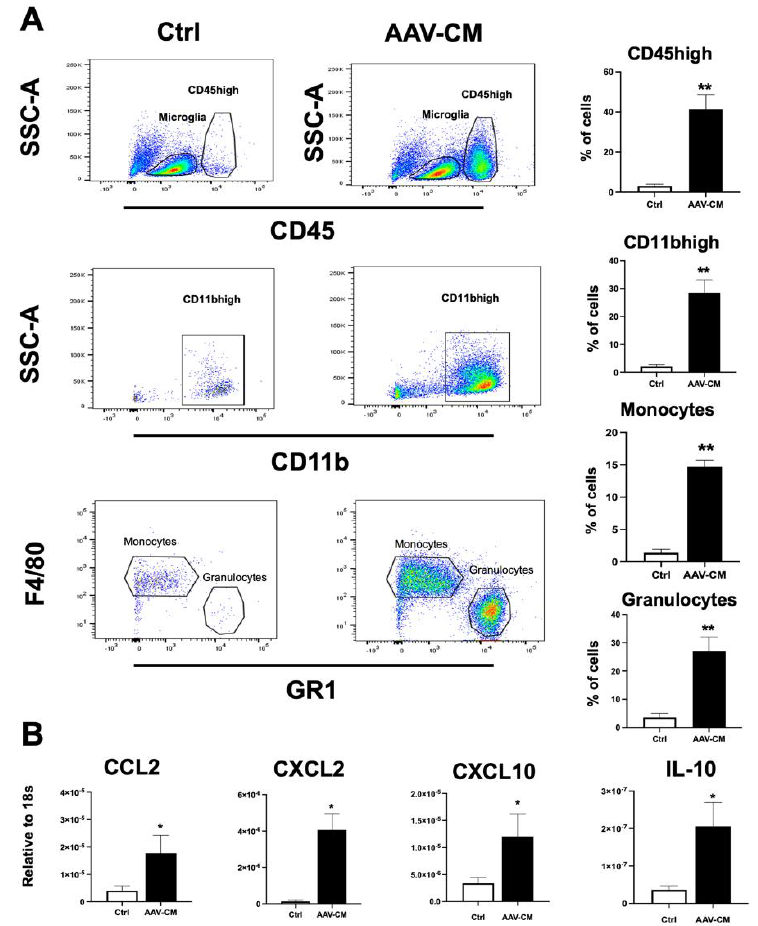
Figure 2. Intrathecal AAV-CM recruits myeloid cells to the healthy CNS. ( A ) Flow cytometric gating strategy to distinguish CD45 high leukocytes from CD45 dim microglia, and CD11b high , macrophages/monocytes (CD45 hi CD11b hi GR1 low/- F4/80 + ), and granulocytes (CD45 hi CD11b hi GR1 hi F4/80 - ). The proportion of CD45 high , CD11b high , monocytes and granulocytes were significantly increased in the CNS tissues of mice upon intrathecal AAV-CM treatment ( n = 4–6 per group). ( B ) RT-qPCR analysis of brains showed CCL2, CXCL2, CXCL10 and IL-10 significantly induced upon intrathecal AAV-CM treatment at 1 day post dose ( n = 4–6). control (ctrl). Data are presented as mean ± SEM. The results were analyzed using the two-tailed Mann–Whitney u-test. * p < 0.05, ** p <